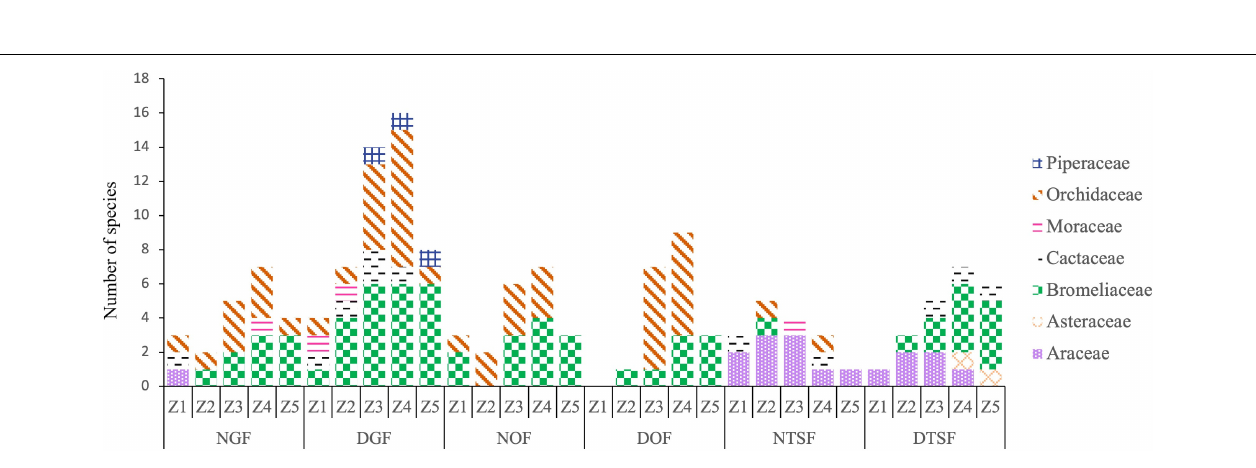
FIGURE 9 | Number of species per family in the vertical zones (ZI, Z2, Z3, Z4, Z5) in each sampling site (NGF = natural gallery forest, DGF = disturbed gallery forest, NOF = natural oak forest, DOF = disturbed oak forest, NTSF = natural tropical sub-deciduous forest, DTSF = disturbed tropical sub-deciduous forest).